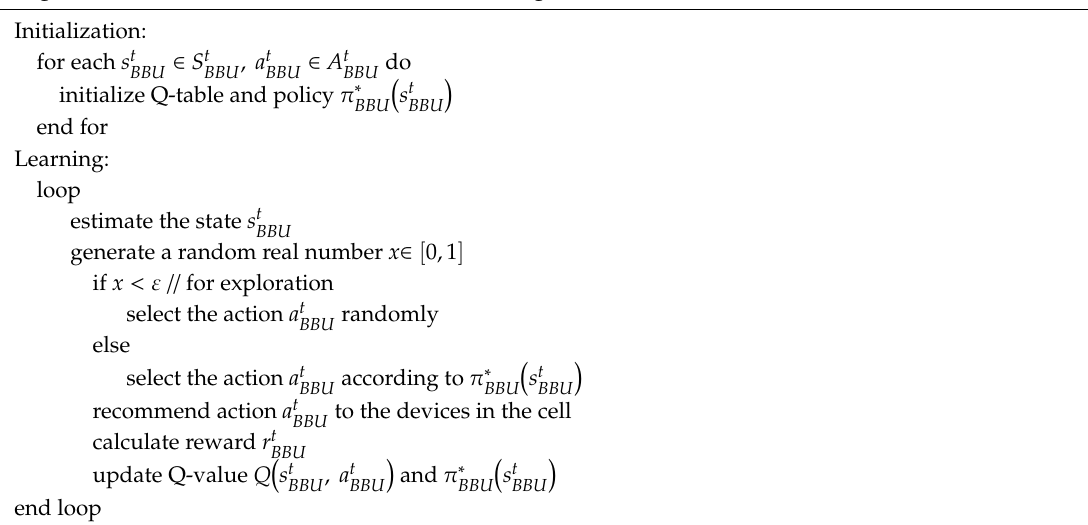
Algorithm 1: Pseudocode for centralized